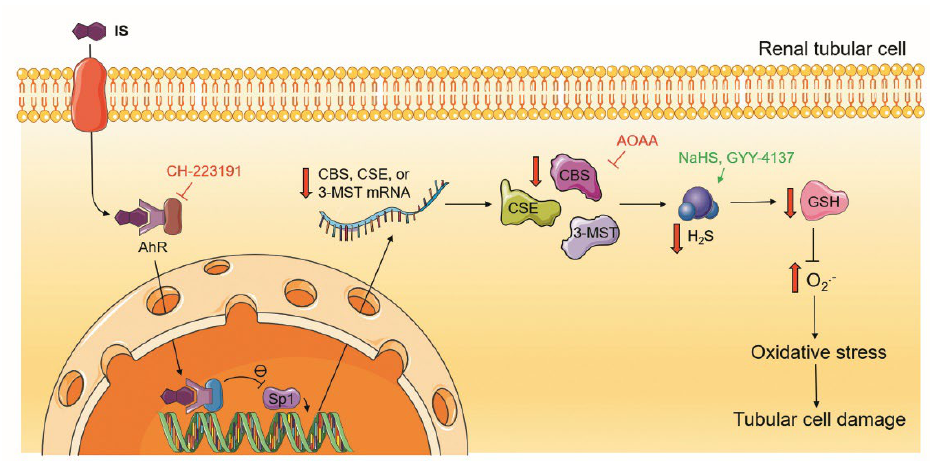
Figure 9. Schematic diagram showing how IS induced renal tubular cell damage. IS was taken up by tubular cells via OATs, as previously reported [11]. IS then decreased the protein activity of transcription factor Sp1. This effect was abolished after the inhibition of AhR via a specific blocker CH-223191, indicating that AhR decreases the DNA binding activity of Sp1. The lowered Sp1 activity probably impaired the protein expression of the H 2 S-producing enzymes CBS, CSE, and 3-MST as well as H 2 S formation. Exogenous H 2 S supplementation through the H 2 S donors NaHS or GYY-4137 ameliorated IS-induced tubular damage by increasing the cellular GSH level and lowering superoxide (O 2 •− ) release. Inhibition of H 2 S-producing enzymes by AOAA exacerbated tubular injury caused by IS via the enhancement of oxidative stress. Parts of the figure were drawn using pictures from Servier Medical Art. Servier Medical Art by Servier is licensed under a Creative Commons Attribution 3.0 Unported License (https://creativecommons.org/licenses/by/3.0/ (accessed on 1 Au- gust 2021)).